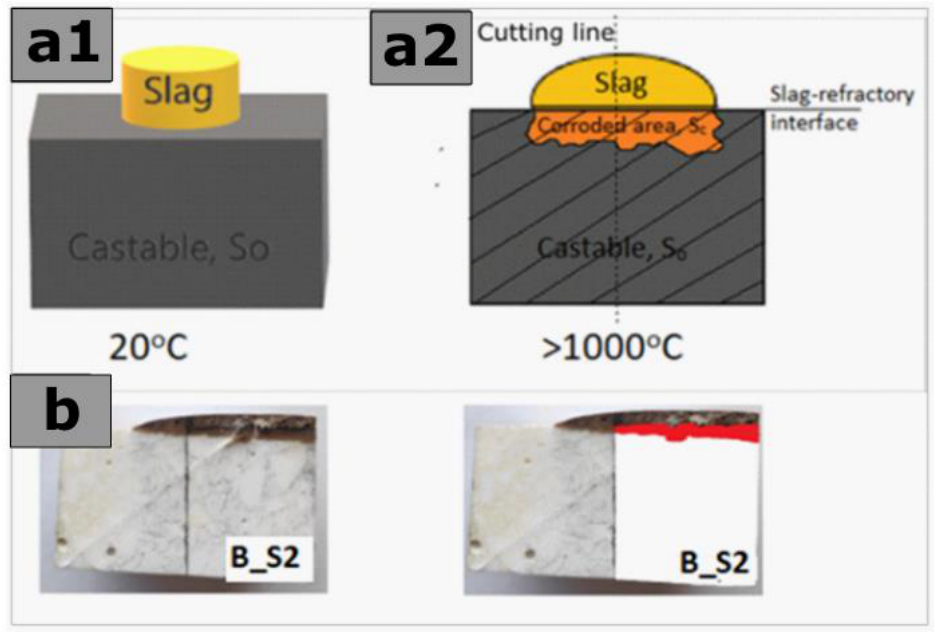
Figure 2. Method of determining the corroded area of castable below slag refractory interface area and the original section area of castable in a graphic program. ( a1 , a2 ) Schematic diagram of stating corrosion test by a coating method; ( b ) real images of the sample after the corrosion test.